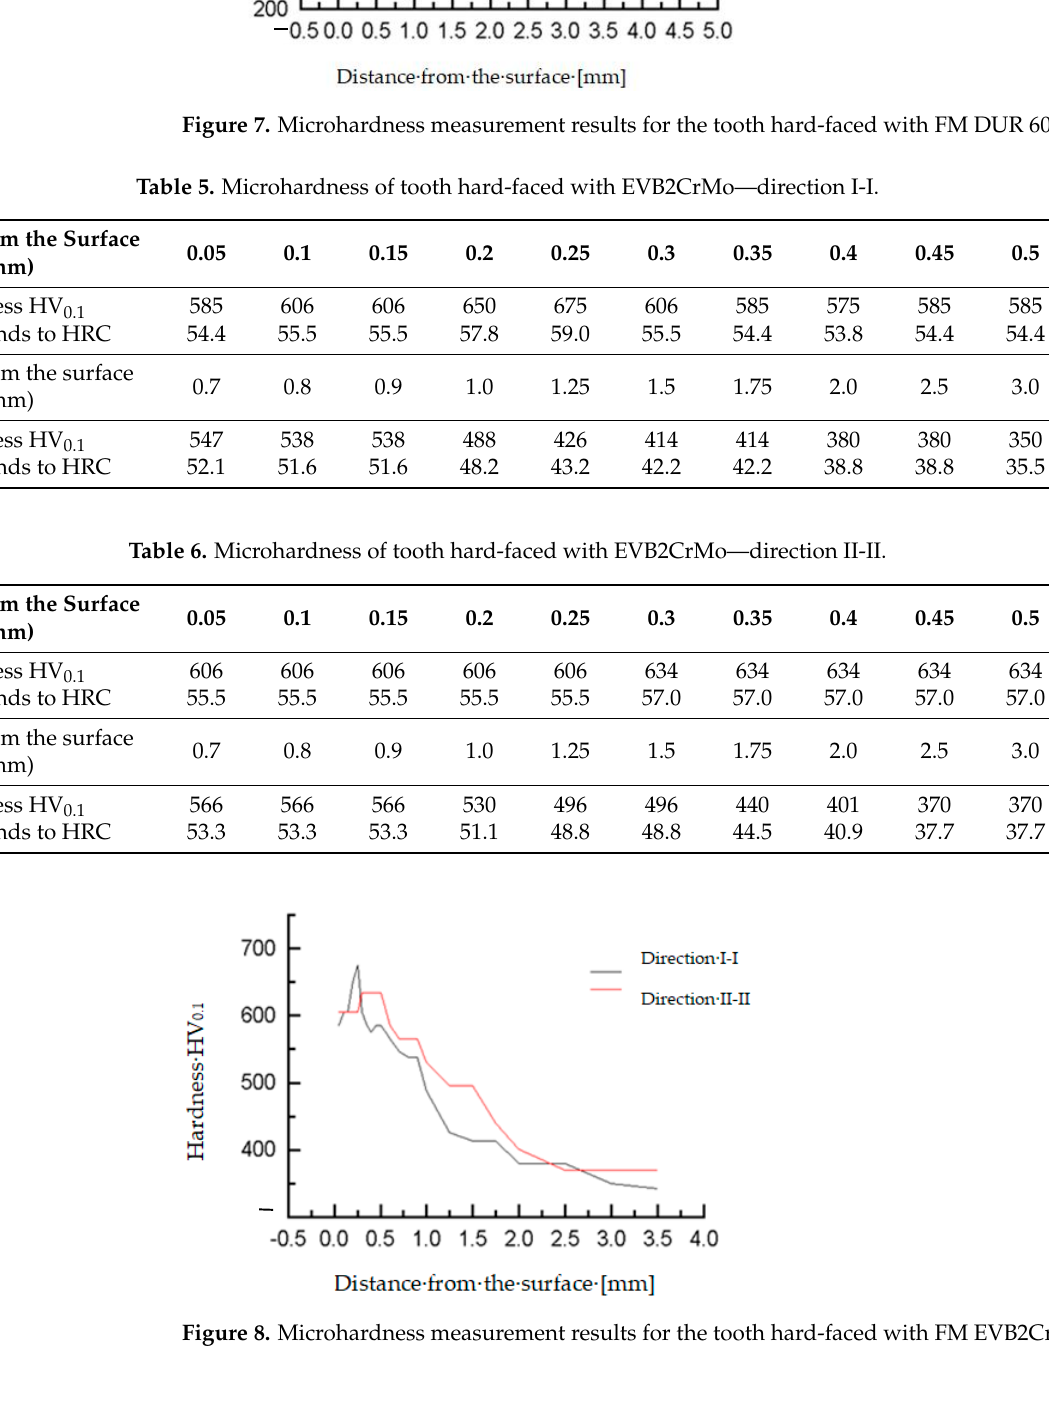
( b ) Figure 9. Microhardness measurements’ directions on the inactive tooth flanks: tooth hard-faced with the DUR 600-IG FM ( a ) and tooth hard-faced with the EVB2CrMo FM ( b ). Table 7. Microhardness of the inactive tooth flank of the tooth hard-faced with the DUR 600-IG FM—direction I-I. Distance from the Surface (mm)